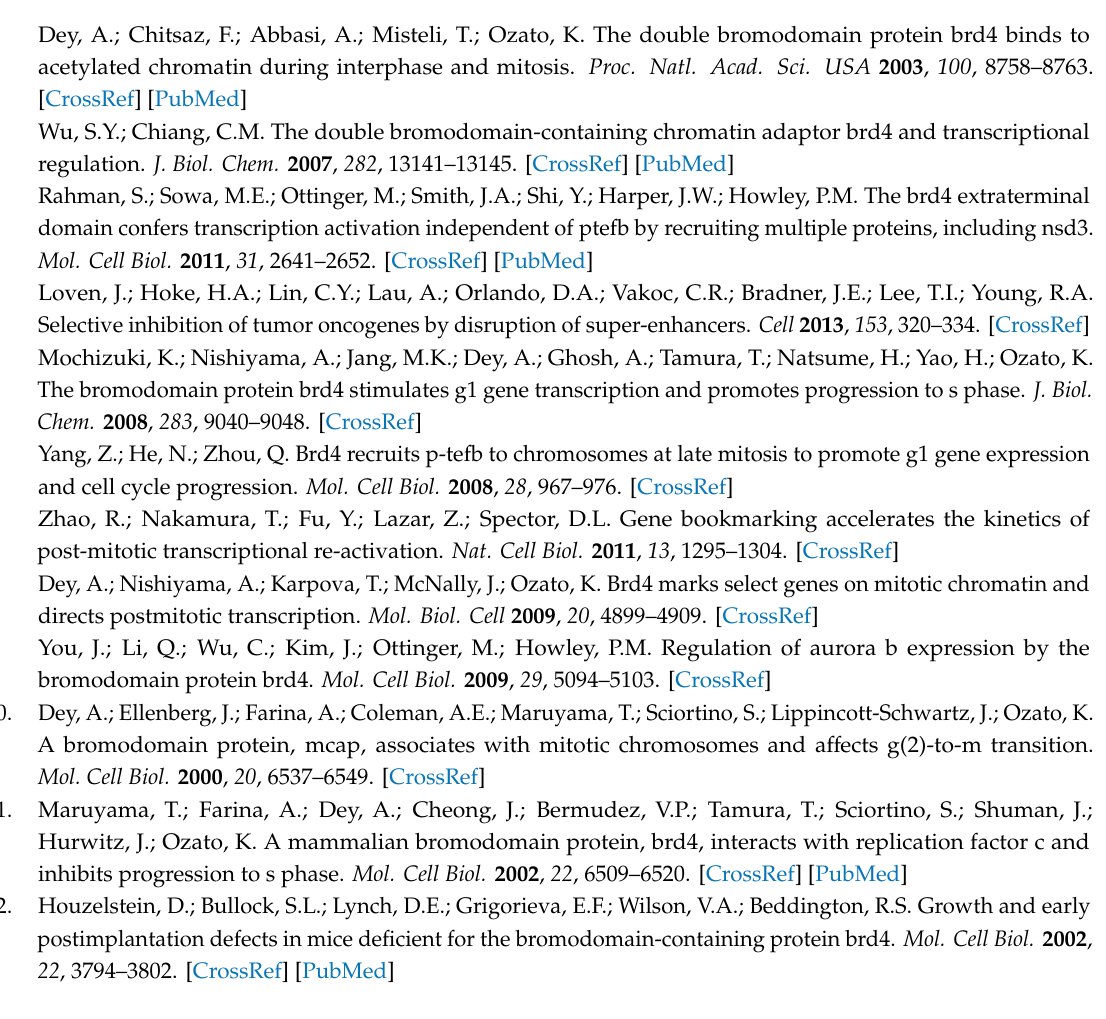
Figure S1: Treatment with anti-microtubule agents induces BRD4 hyperphosphorylation, Figure S2: BRD4 could be phosphorylated with insect-expressed CDK1 / Cyclin B1 in vitro, Figure S3: BRD4 WT and 4A show similar a ffi nity to chromatin, Figure S4: CDK1 is a potential kinase that mediates BRD4 mitotic hyperphosphorylation, Figure S5: BMS-265246 treatment shows more e ff ect on NUT midline carcinoma-specific BRD4 hyperphosphorylation